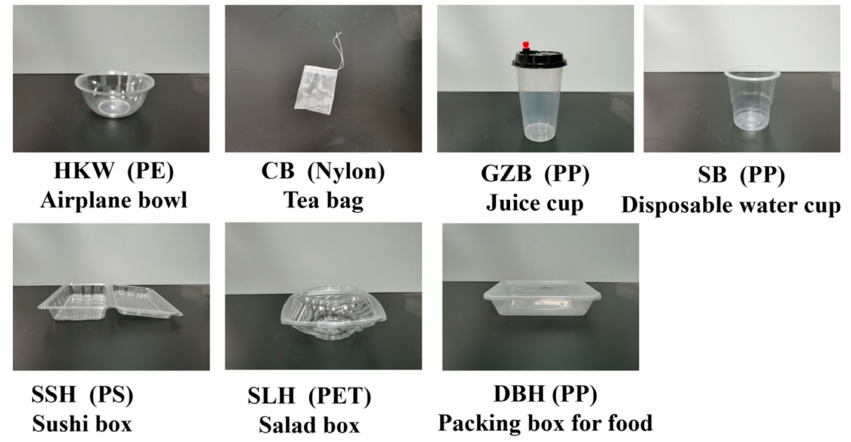
Figure 1. Seven types of takeaway food